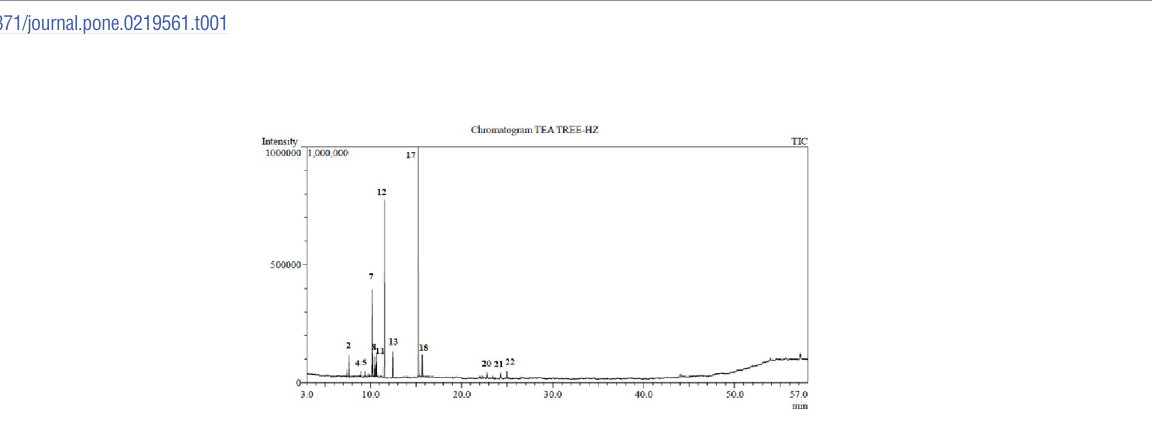
Fig 1. GC/MS chromatogram of the essential oil of Melaleuca alternifolia (Tea